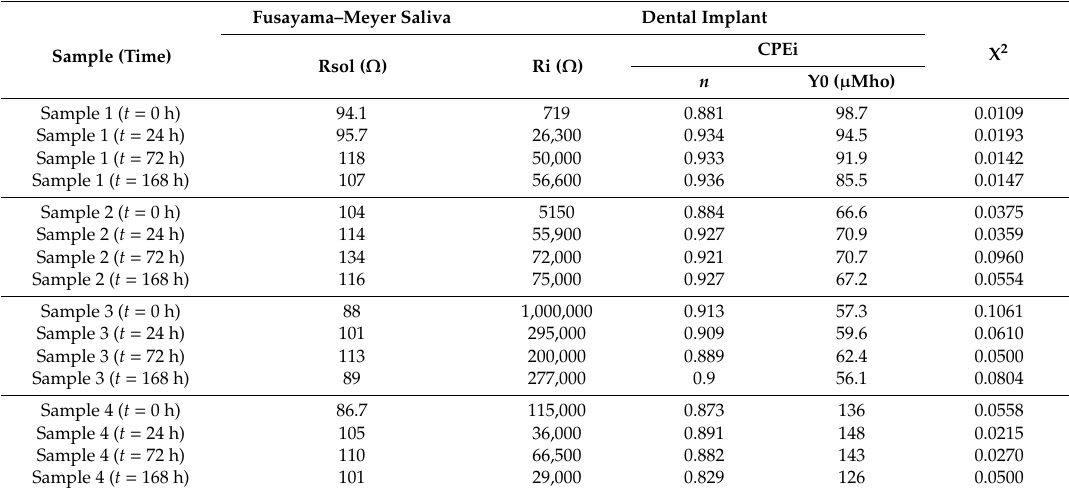
Table 2. Electrical circuit parameters for Samples 1–4 (at t = 0, 24, 72, and 168 h).